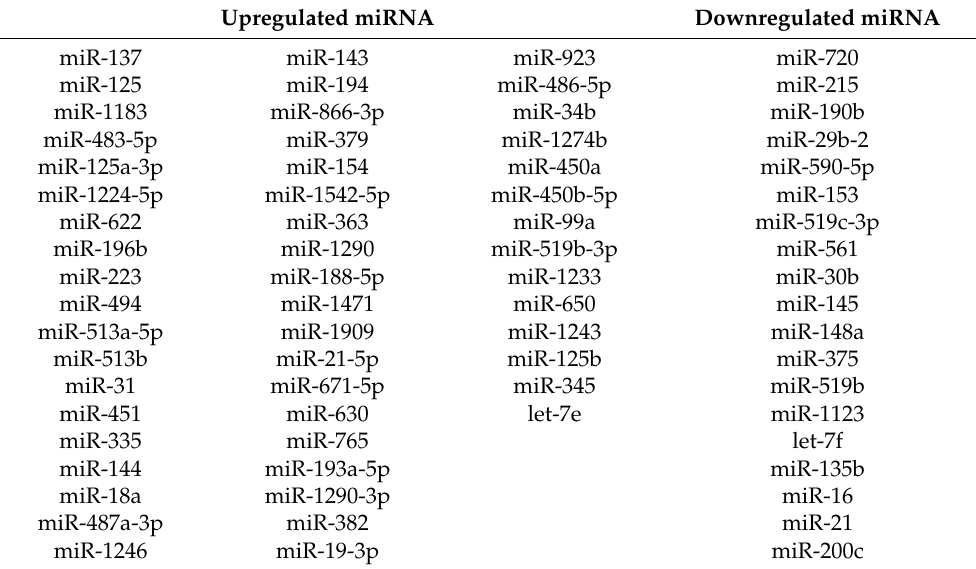
Table 4. MicroRNA in rectal cancer associated with response to